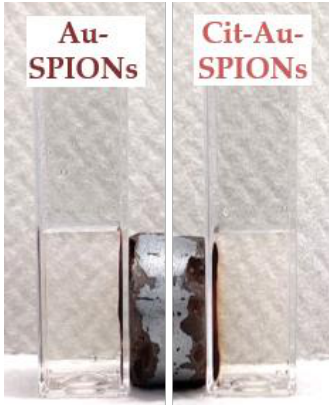
Figure A3. Magnetic separation of Au-SPIONs and Cit-Au-SPIONs after 8 h showed clear supernatants, which indicated that the gold was reduced onto the SPION cores instead of forming unattached nanosized gold that would appear red in the supernatant.